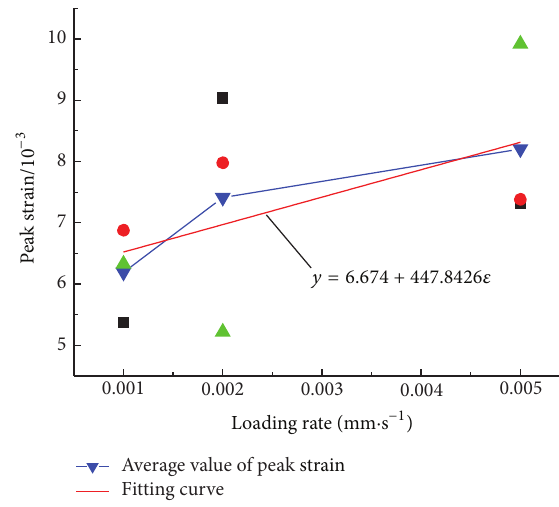
Figure 5: The relationship between peak strain and loading rate.